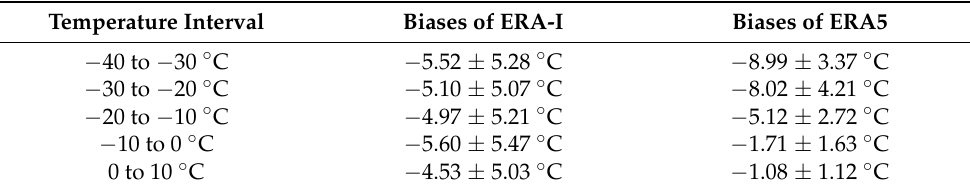
Table 4. Biases between the buoy observations and the reanalysis datasets based on temperature intervals in terms of Ts.